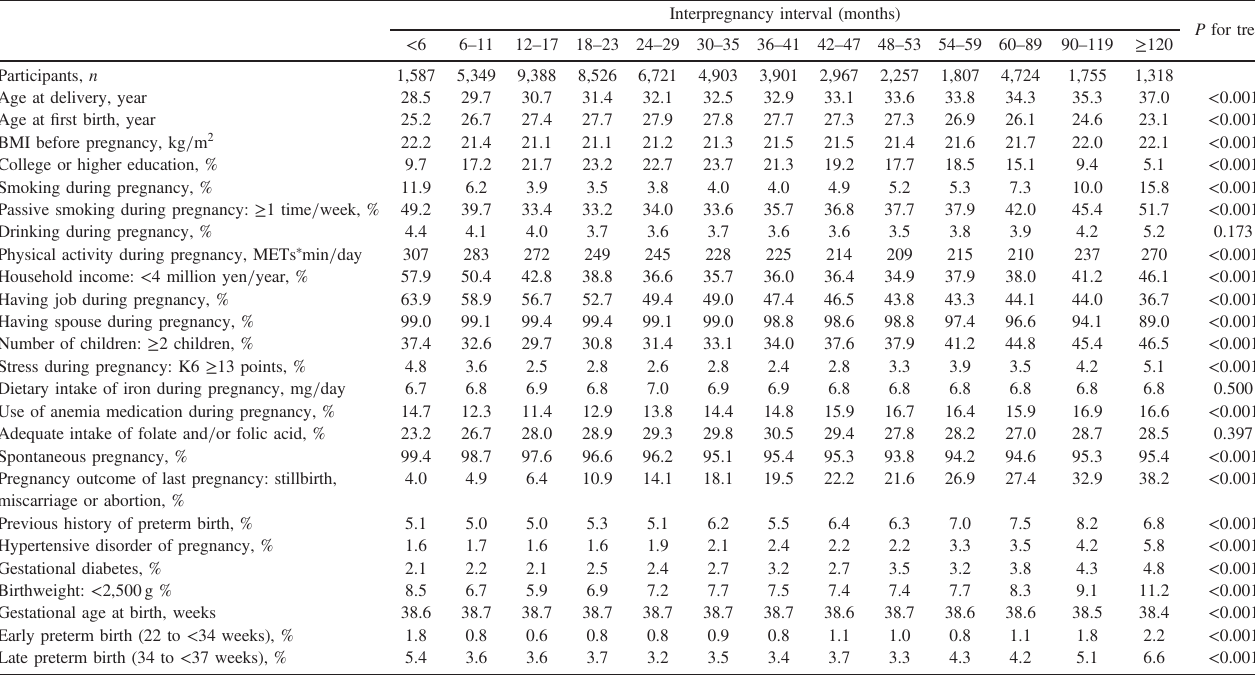
Table 1. Mean and prevalence of characteristics according to interpregnancy interval in the 55,203 pregnancies